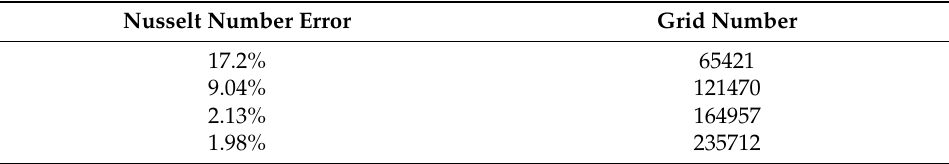
Figure 4. Considered grid for proposed geometry as PTC. Table 4. Outcomes of the grid independence